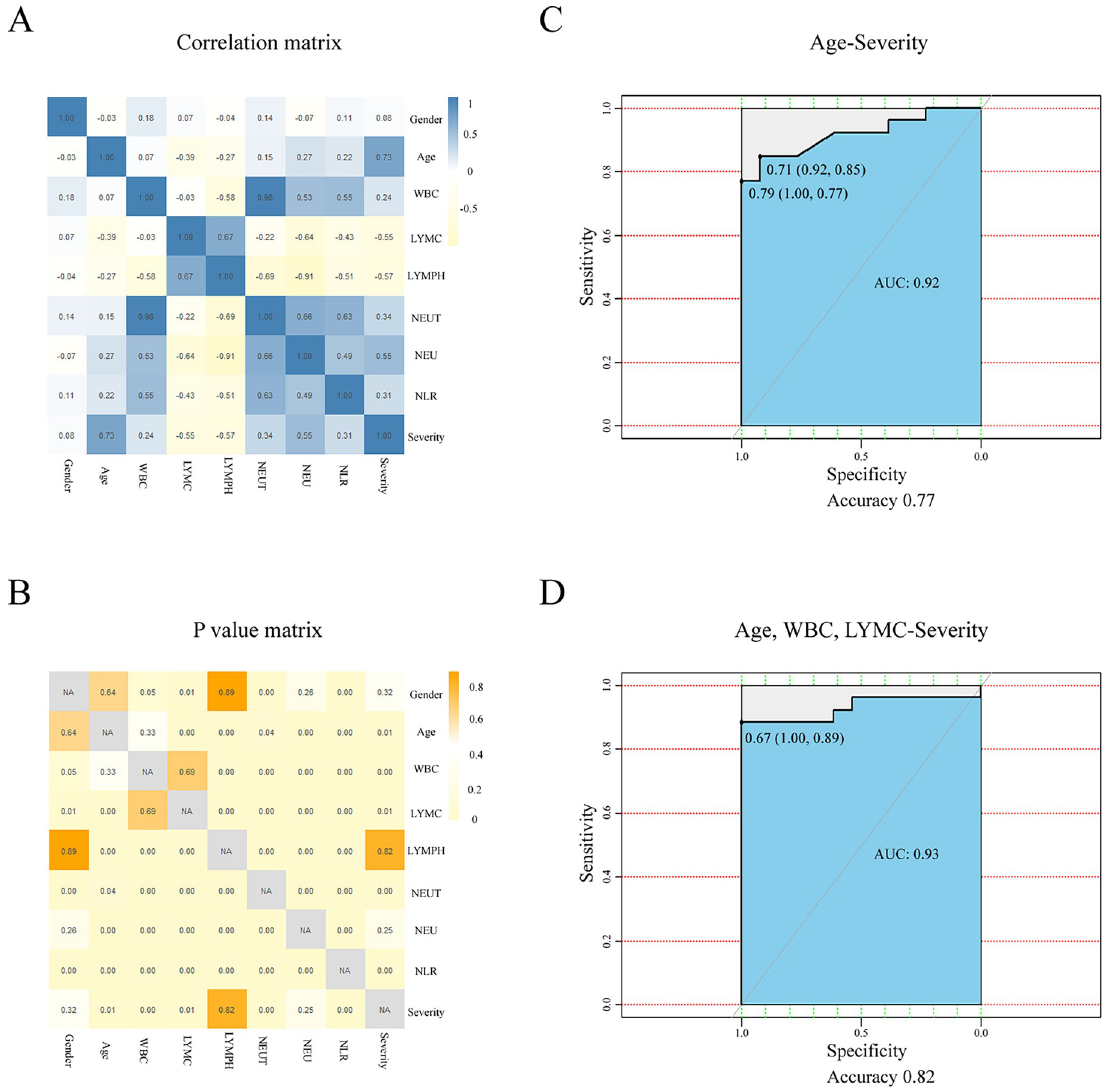
Fig 2. The correlation between clinic characteristics and severity of COVID-2019 and the predictive value of clinic characteristics for the severity of COVID-19. (A). Correlation analysis: Characteristics of the COVID-19 patient including Gender, Age WBC, LYMC, LYMPH, NEUT, NEU, NLR and Severity. WBC, LYMC, LYMPH, NEUT, NEU and NLR were extracted form patients’ initial blood test results. Patients were divided into Mild-Moderate and Severe-Critically Severe groups according to the 8th edition of the China Guidelines for the Diagnosis and Treatment Plan of COVID-19 Infection by the National Health Commission (Trial Version 8). According to the characteristics of the data, the correlation was calculated based on the Kendall correlation coefficient (Gender-severity) or Spearman correlation coefficient. P < 0.05 was considered statistically significant. (B). P-values of correlation. (C). ROC curve used to evaluate the predictive value of Age for the severity of COVID-19 based on stratified random sampling: 80% as the training set and 20% as the testing set. (D). ROC curve used to evaluate the predictive value of Age, WBC, LYMC for the severity of COVID-19 based on stratified random sampling: 80% as the training set and 20% as the testing set. repeatedly run the algorithm. The average number of features selected by 3 different criteria, EVAL1, EVAL1 (subset) and EVAL1+EVAL2 (subset) are 6.58 (95% CI: 6.48–6.68), 3.26 (95% CI: 3.01–3.51) and 3.52 (95% CI: 3.40–3.64), respectively (Fig 4A). The criteria, EVAL1 +EVAL2 (subset), adopted by the MCDM algorithm improved most performance metrics. The metrics (ACC, TPR, FPR and F1 score) of EVAL1+EVAL2 (subset) are 0.81 (95% CI: